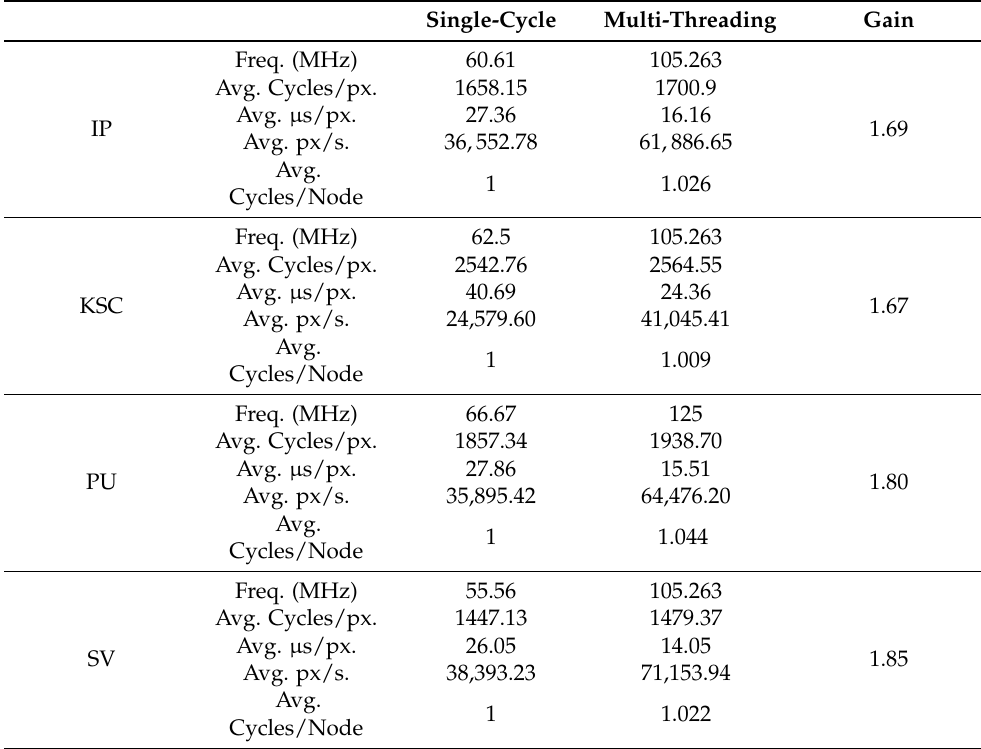
Table 3. Single-cycle vs. multi-threading throughput.